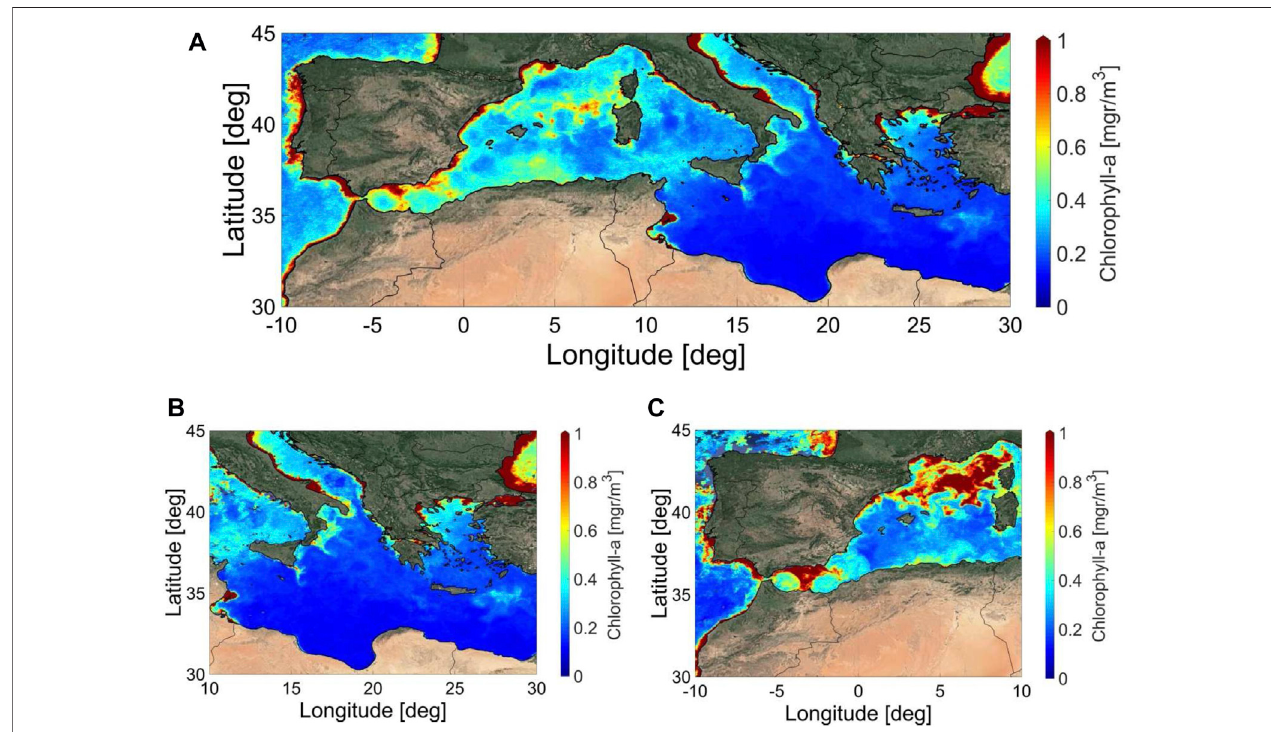
FIGURE 3 | Monthly mean (March 2018) (A) and 8 day average sea surface Chlorophyll- a concentration in the Mediterranean Sea for the fi rst (06-13/03/2018) (B) and second (30/03/2018-06/04/2018-right) (C) part of the MSM72 cruise.